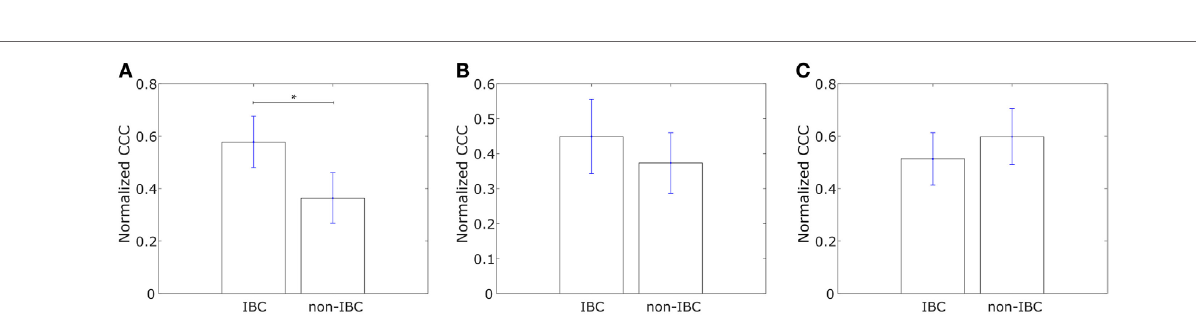
FigUre 1 | Normalized cophenetic correlation coefficient of the collective dissemination-associated gene network for (a) 13 epithelial (E) and 11 mesenchymal cell lines from the study by Grosse-Wilde et al. (39), and (B) 11 epithelial (E) and 47 hybrid epithelial-mesenchymal (E/M) + mesenchymal (M) cell lines from the NCI60 dataset (41, 42). Error bars indicate the SE in the estimate of CCC norm calculated using the bootstrap method. * p -Value < 0.05.